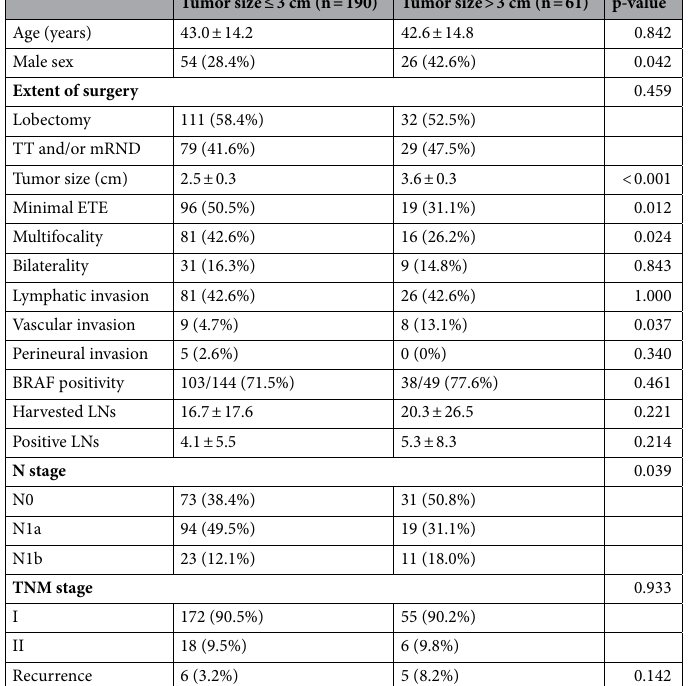
Table 3. Baseline clinicopathological characteristics according to tumor size. Data were expressed as number (%) or mean ± standard deviation. A statistically significant difference was defined as p < 0.05. TT total thyroidectomy, mRND modified radical neck dissection, ETE extrathyroidal extension, LN lymph node, T tumor, N node, M